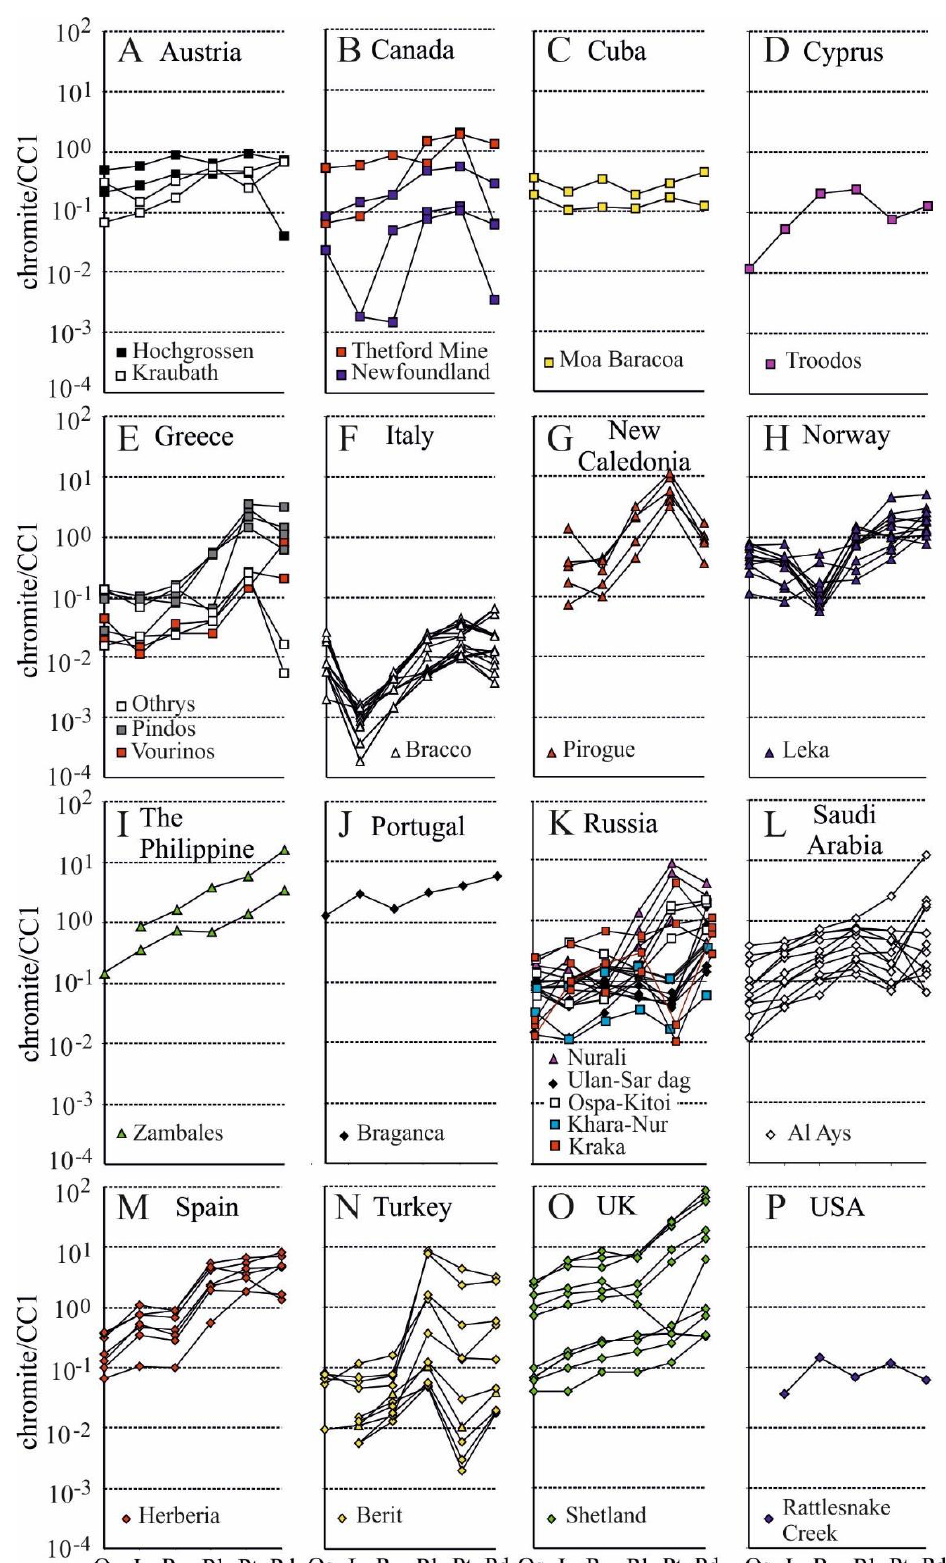
Figure 3. Chondrite [61]-normalized patterns of the overviewed chromitites, according to their geographical location. ( A ) Austria, ( B ) Canada, ( C ) Cuba, ( D ) Cyprus, ( E ) Greece, ( F ) Italy, ( G ) New Caledonia, ( H ) Norway, ( I ) The Philippines, ( J ) Portugal, ( K ) Russia, ( L ) Saudi Arabia, ( M ) Spain, ( N ) Turkey, ( O ) UK, ( P ) USA. See Table 2 for data source and references.